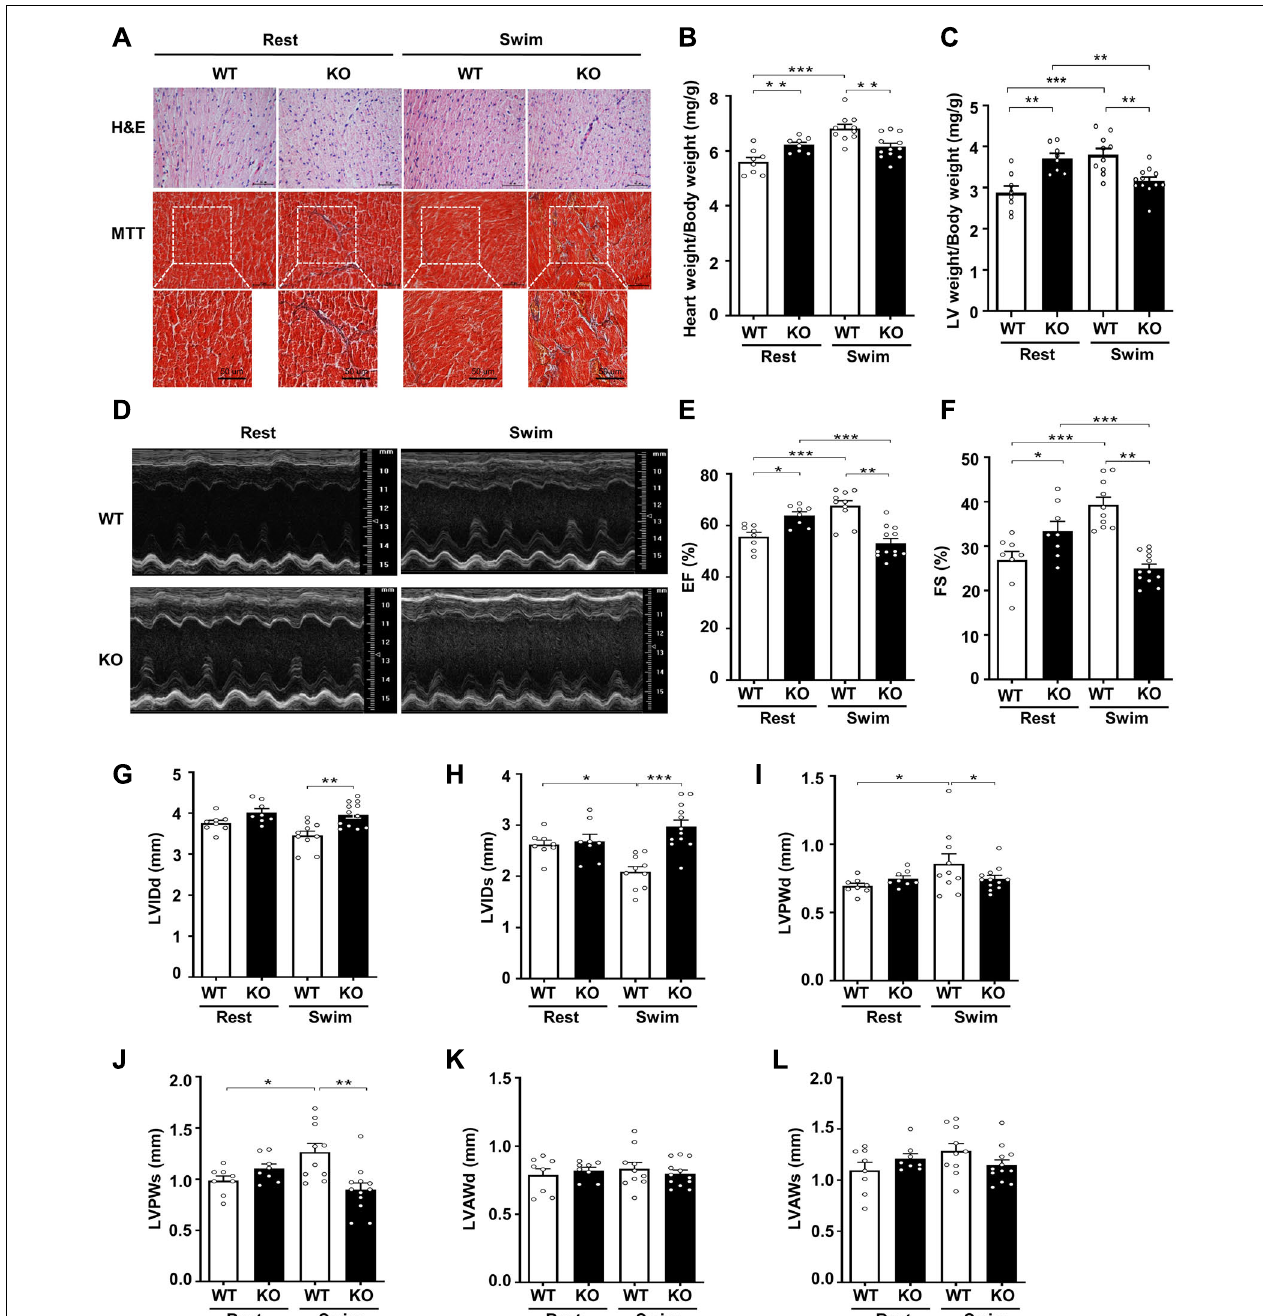
FIGURE 2 | Physiological stress-swimming exercise causes pathological cardiac remodeling in CKIP-1-deficient mice. (A) Top, representative images of hematoxylin and eosin staining in hearts from WT and CKIP-1 KO aged (2-month-old) mice after rest or swimming exercise. Scale bars, 50 µ m. Bottom, representative images of heart sections stained with Masson’s trichrome. Scale bars, 50 µ m. (B) Heart weight (HW) to body weight (BW) ratios in WT and CKIP-1 KO mice with rest or swimming exercise. (C) Quantification of LV weight/body weight. (D–F) Cardiac function was monitored via echocardiography at 3 weeks after swimming exercise: (D) representative M-mode echocardiographic images of each study group at 3 weeks; (E) ejection fraction (EF) in WT-Rest, KO-Rest, WT-Swimming, and KO-Swimming mice; (F) fractional shortening (FS) in WT and CKIP-1 KO mice after rest or swimming exercise. (G–L) Quantitative analysis of the diastolic and systolic left ventricular internal diameter (LVIDd and LVIDs), LV posterior wall thickness (LVPWd and LVPWs), and LV anterior wall thickness (LVAWd and LVAWs) from WT and KO mice by echocardiography after swimming exercise. Values are means ± SEM, n = 8 ∼ 12, ∗ P < 0.05, ∗∗ P < 0.01, ∗∗∗ P < 0.001. Statistical differences among groups were analyzed by two-way analysis of variance (ANOVA) followed by the Bonferroni procedure. CKIP-1, casein kinase-2 interacting protein-1; WT, wild type; KO, knockout; LV, left ventricular.